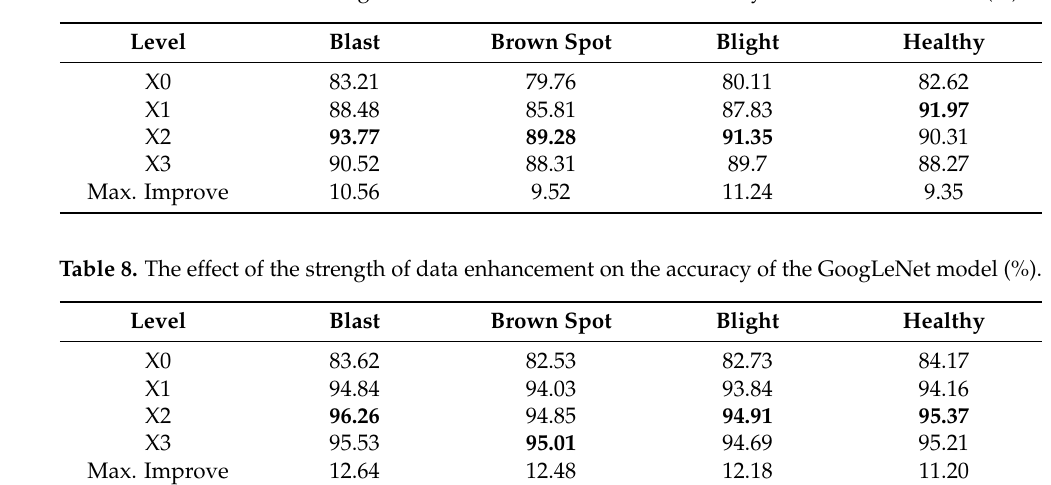
Table 7. The effect of the strength of data enhancement on the accuracy of the VGG-16 model (%).